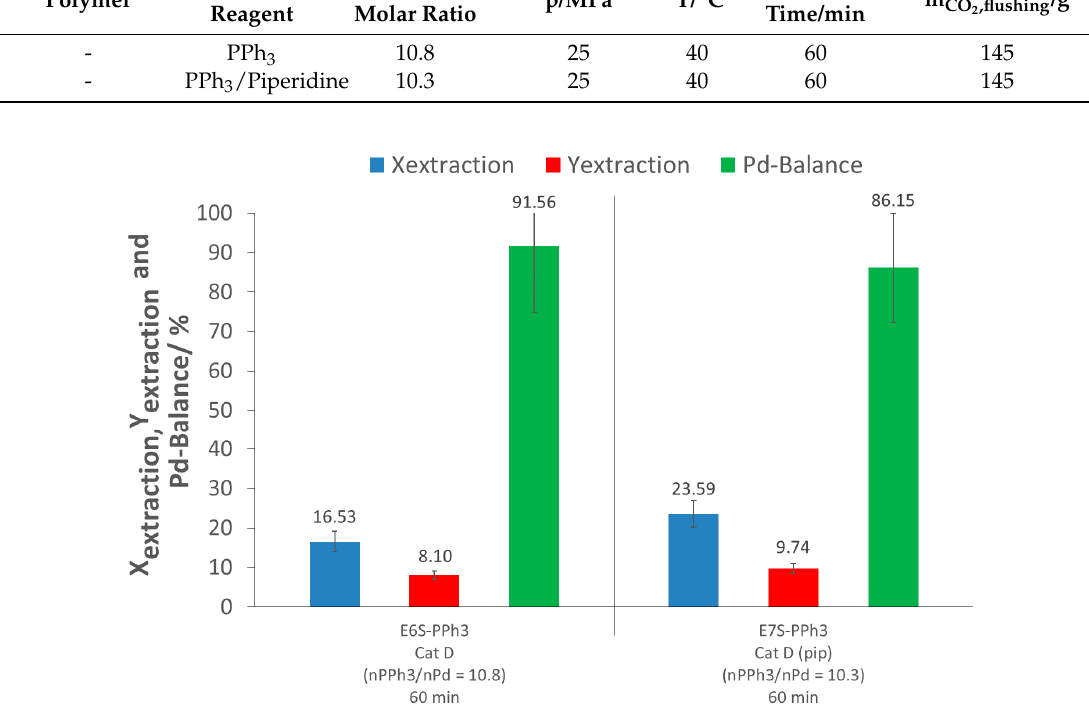
Figure 4. Results of the PPh 3 extractions ((pip): piperidine; nPPh 3 /nPd: molar ratio of PPh 3 to Pd; ExS-PPh3: Screening experiments). ExS-PPh 3 : Screening